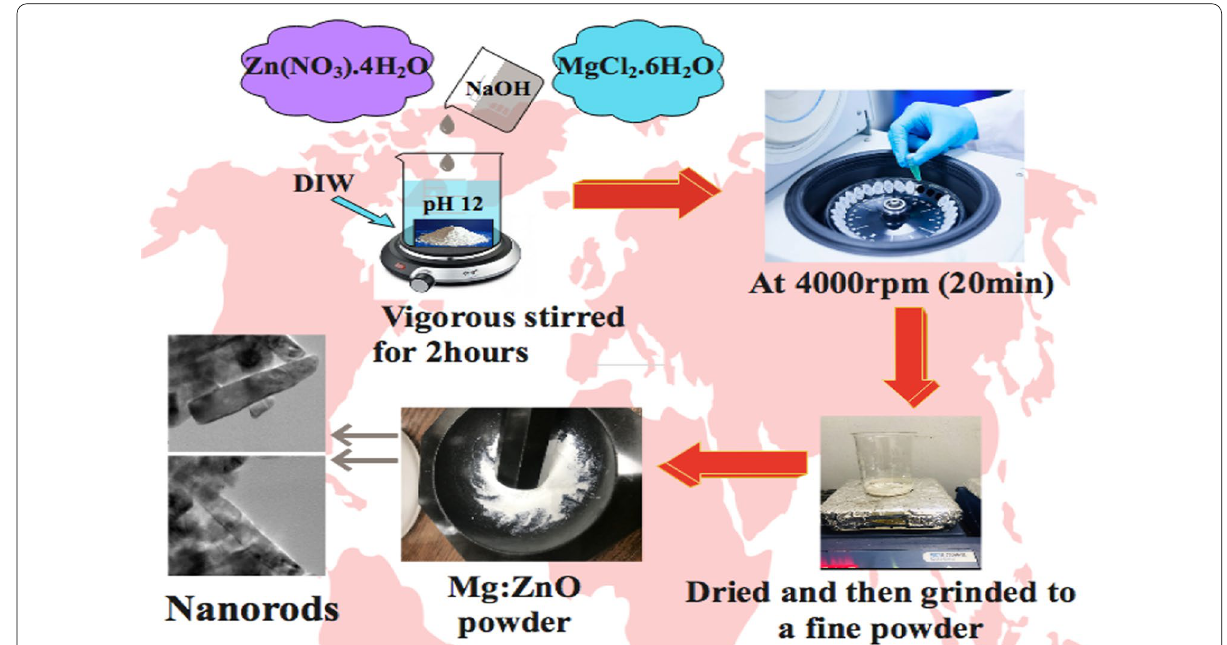
Fig. 1 Schematic illustration of the synthesis stratagem of Mg‑doped ZnO